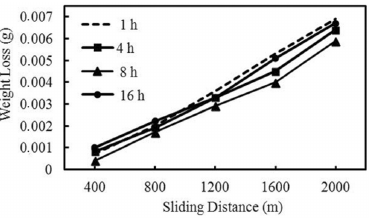
Figure 5. Weight losses in different synthesizing time and sliding distances A356+6% Ti AMCs.